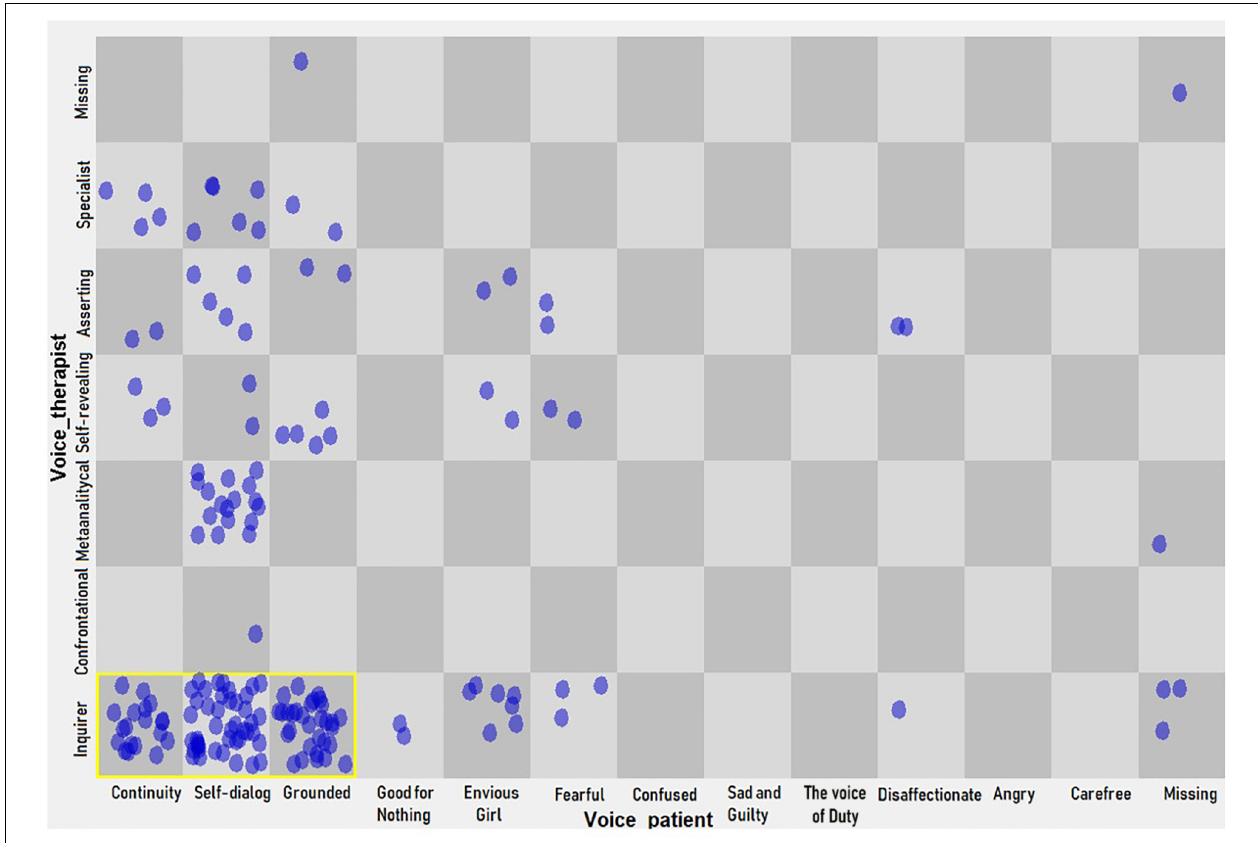
FIGURE 5 | Dynamic pattern in voices of the patient and her therapist (level 3, change